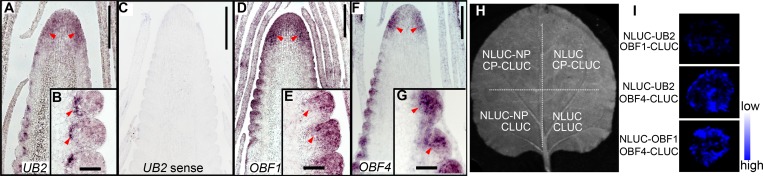
mRNA expression patterns of KRN4 binding proteins.(A-G), mRNA in situ hybridization of UB2 (A-C), OBF1 (D, E) and OBF4 (F, G) in 2–3 mm B73 ears using anti-sense probes, (C) UB2 sense probes as a negative control. The arrows refer to the signal regions. (H, I) Protein–protein interaction identified by a luciferase complementation image assay. (H) Diagram of the experimental design on a single tobacco leaf, including one treatment (upper left) and three control groups. (I) Interaction signals of UB2-OBF1, UB2–OBF4 and OBF1–OBF4. NLUC and CLUC represent N-terminal and C-terminal domains of Firefly Luciferase, respectively. NP and CP, NLUC-fused protein and CLUC-fused protein detected in the luciferase complementation image assay, respectively.